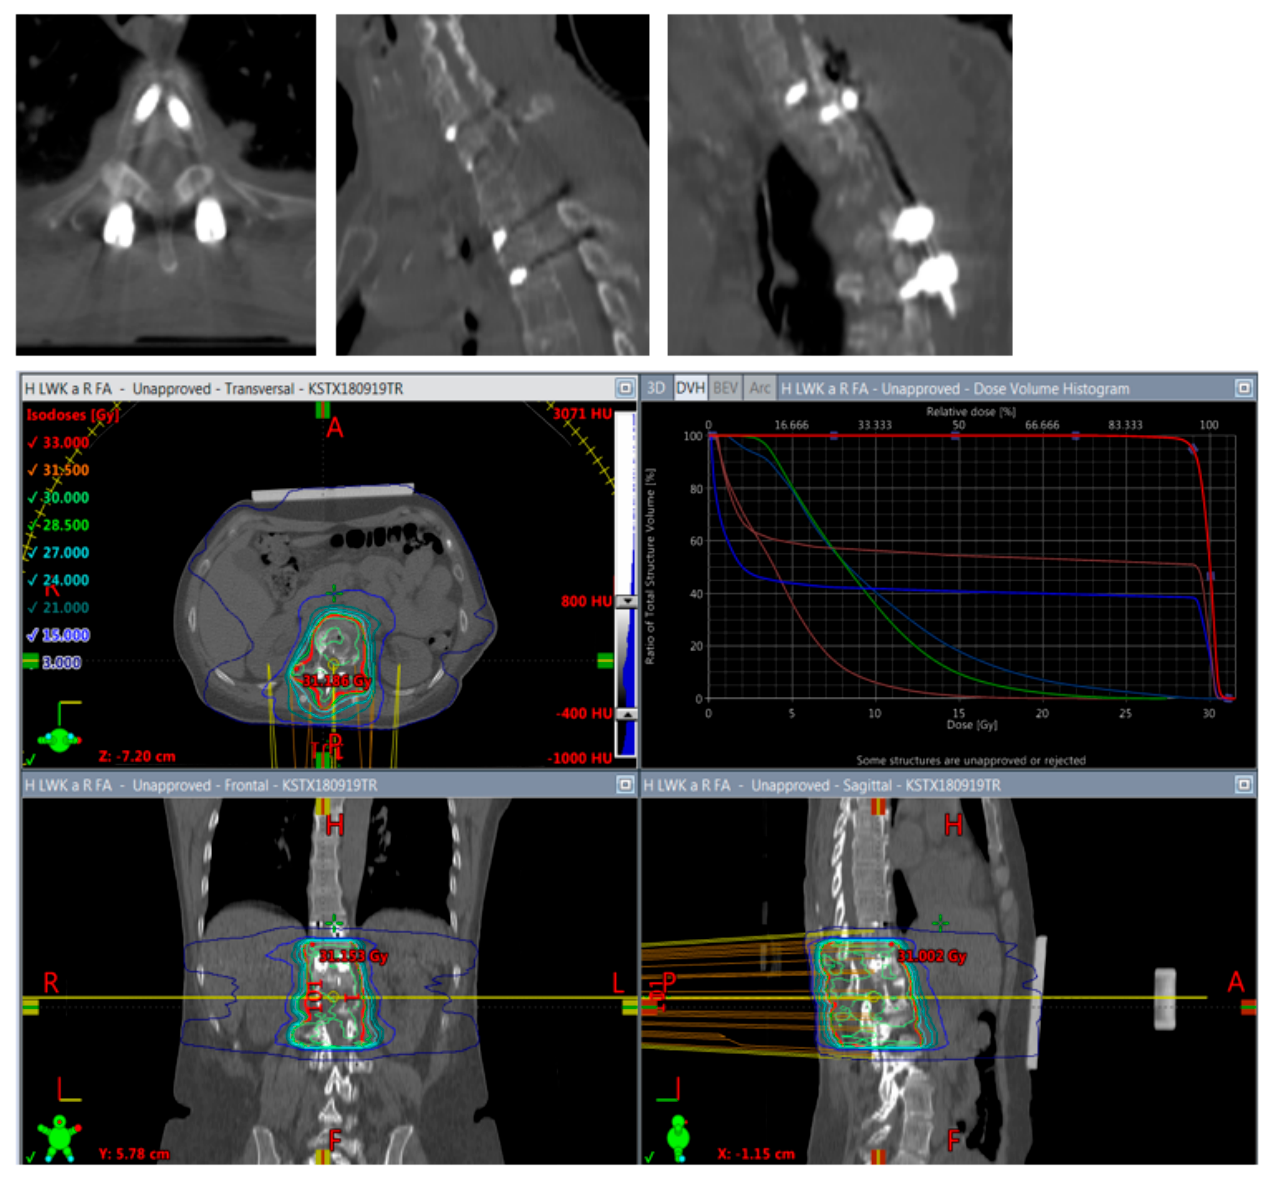
Figure 5. Planning of postoperative radiotherapy: titan. Planning of conventional radiotherapy (30 á 3 Gy) of the vertebral body plus all instrumented levels.